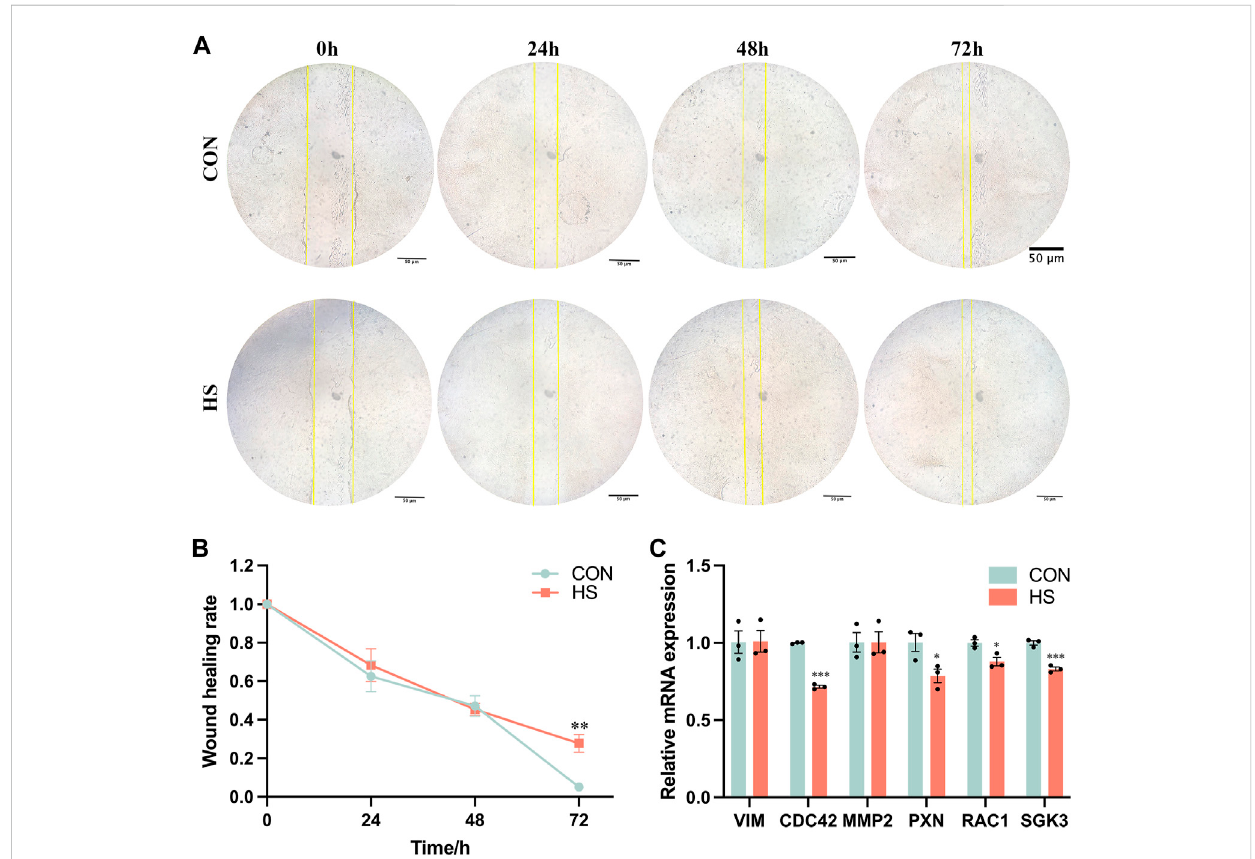
FIGURE 4 Heat stress inhibited the cell migration of myoblasts. (A) Representative images of the myoblasts by a wound-healing assay. (B) The wound healing rate of the myoblasts. (C) mRNA expression of the migration-related genes in myoblasts by RT-qPCR. All data are shown as the mean ± SEM (n = 3, * p < 0.05; ** p < 0.01, *** p <